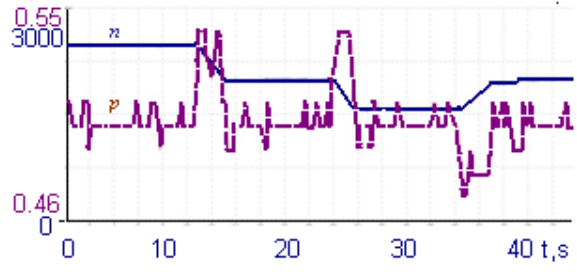
Fig. 7. Experimental pressure and speed